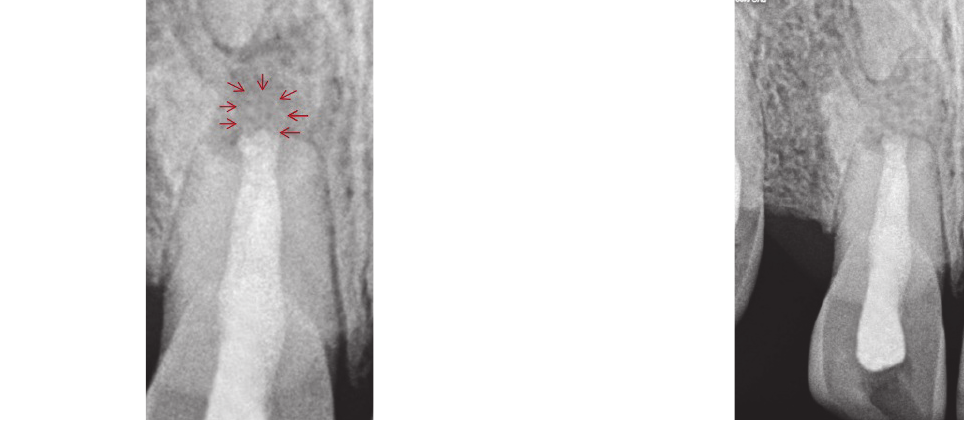
Figure5:10-monthfollow-upofthecaseshowscompletelyresorbed matrix and bone healing in the periapical